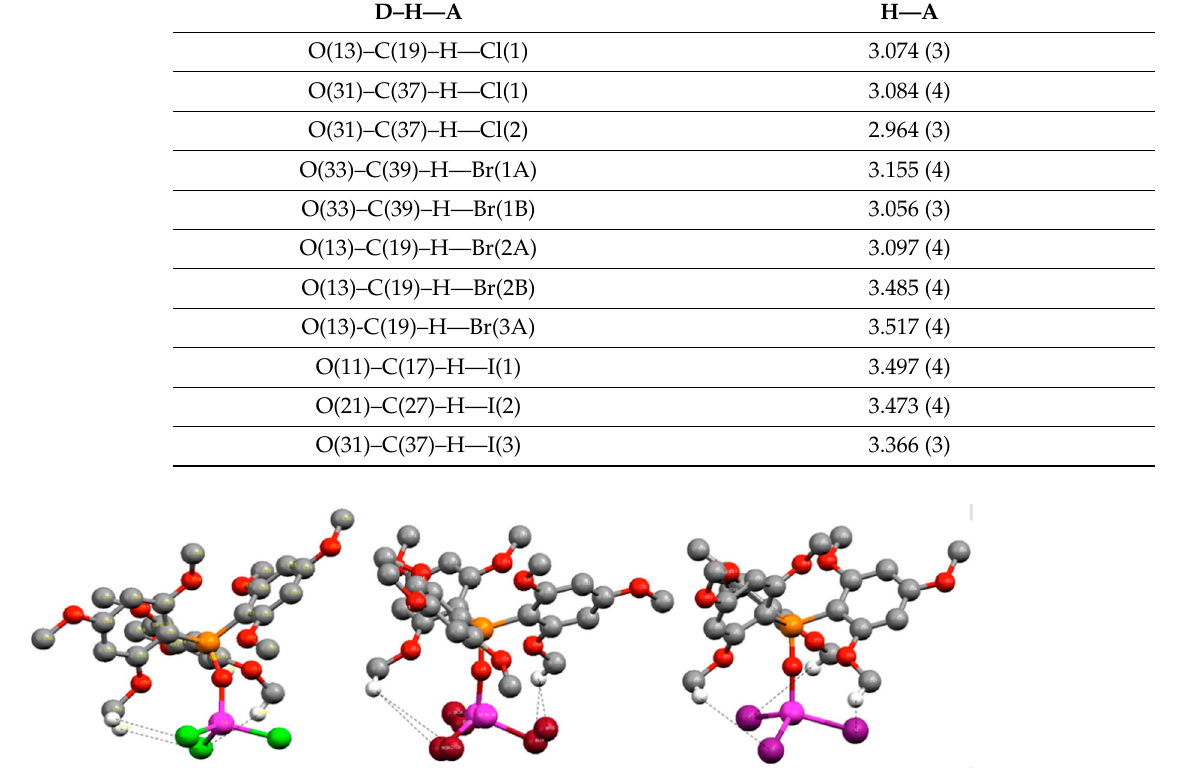
Table 2. Hydrogen bonding in 1, 2 and 3 (Å).